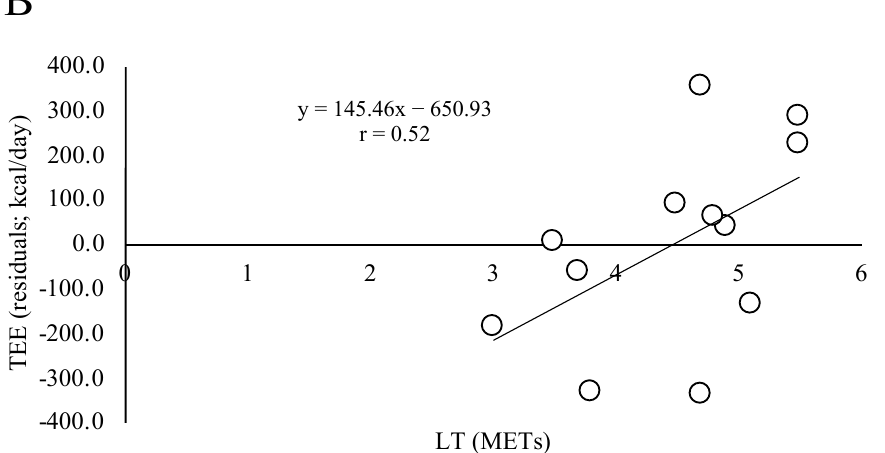
Figure 2. Relationship between LT and the residuals adjusted for TEE by body mass ( A ); LT and the residuals adjusted for TEE by FFM ( B ).